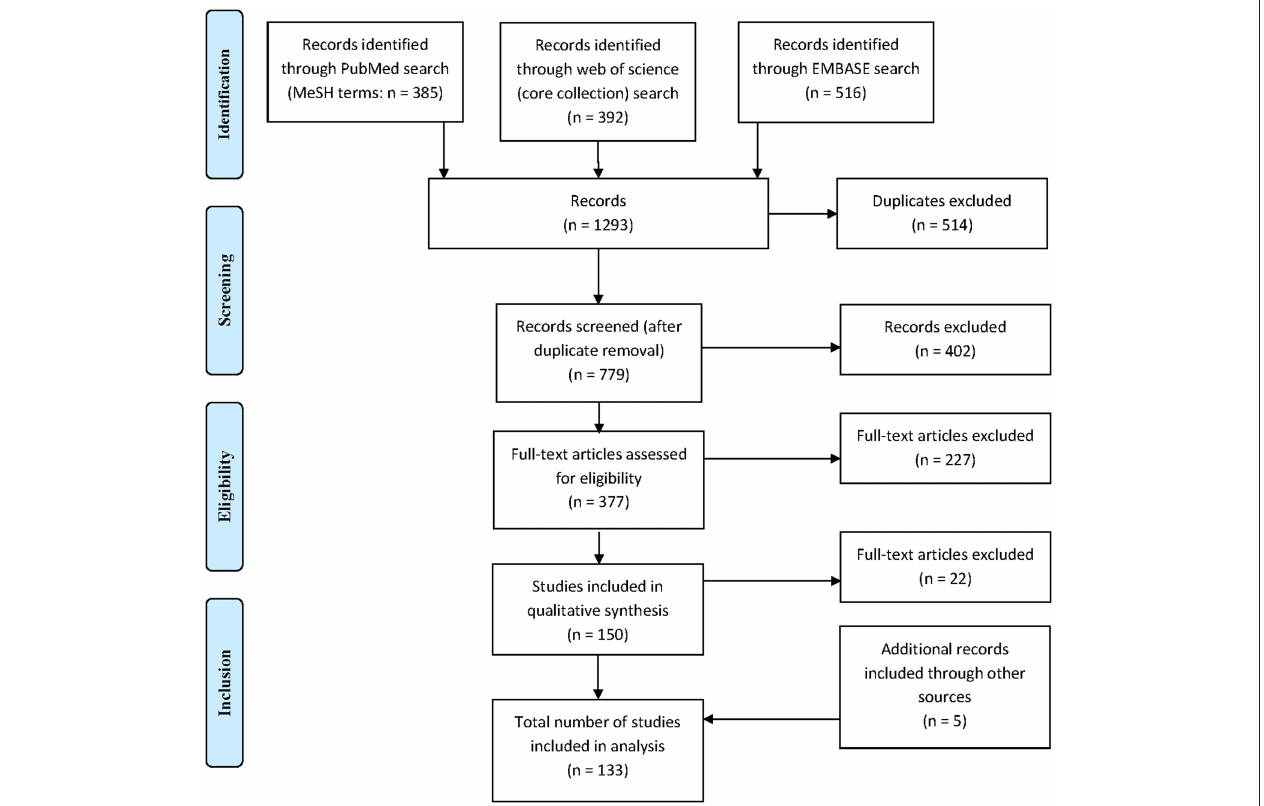
FIGURE 1 | Flow chart outlining selection of articles included in the